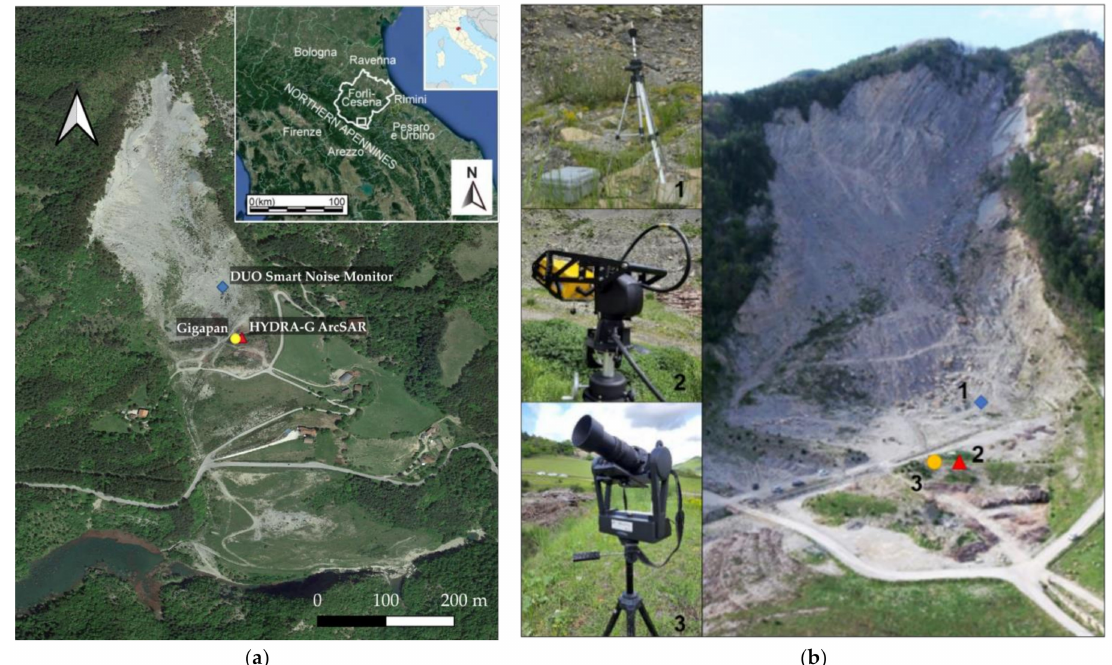
Figure 1. Operational ground-based remote sensing tools during the intensive monitoring campaign at Poggio Baldi Landslide Natural Laboratory (PBL): ( a ) Top view of the slope including the location of monitoring instruments. Upper right inset with enclose the geographical frame of the Forl ì -Cesena province in the Northern Apennines; ( b ) UAV picture of the Poggio Baldi landslide upper slope and the corresponding positions of 01dB DUO Smart Noise Monitor (1), HYDRA-G ArcSAR (2) and GigaPan Epic Pro V system (3) about the rock cliff under